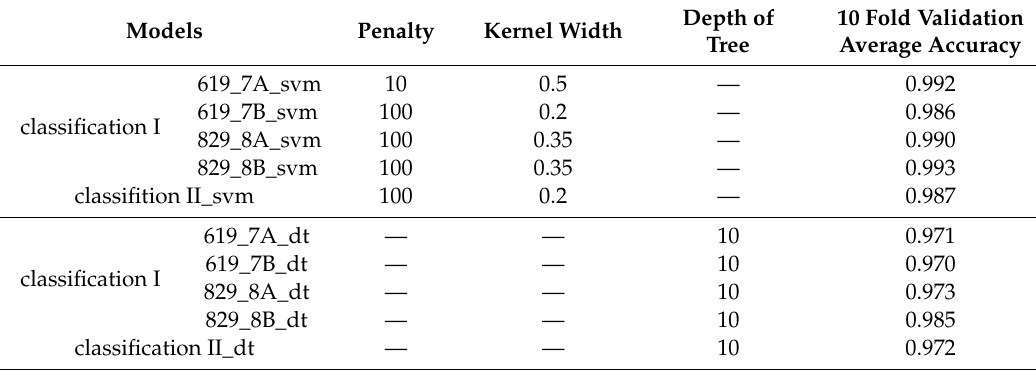
Table 4. Parameters of classifier models and average accuracy of 10-fold